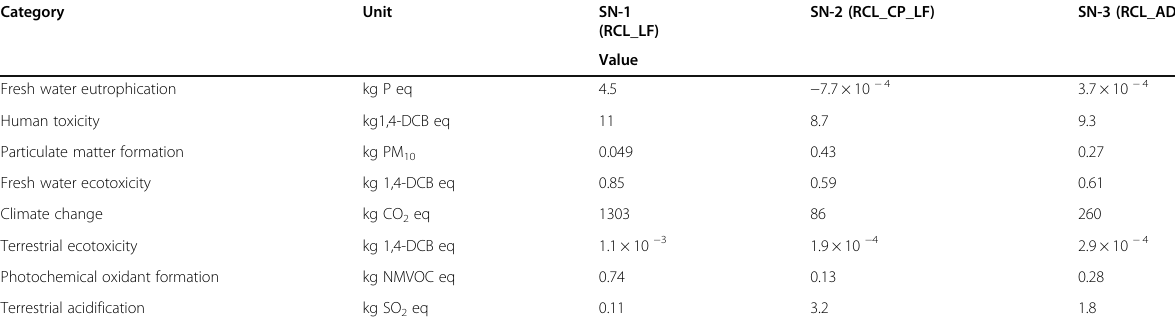
Table 7 Environmental impacts results with resources recovery Category